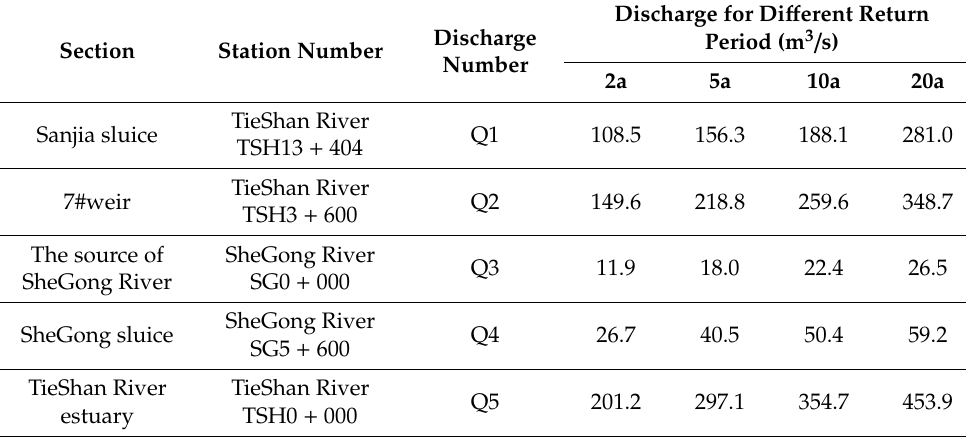
Table 1. Discharge of each calculated section of